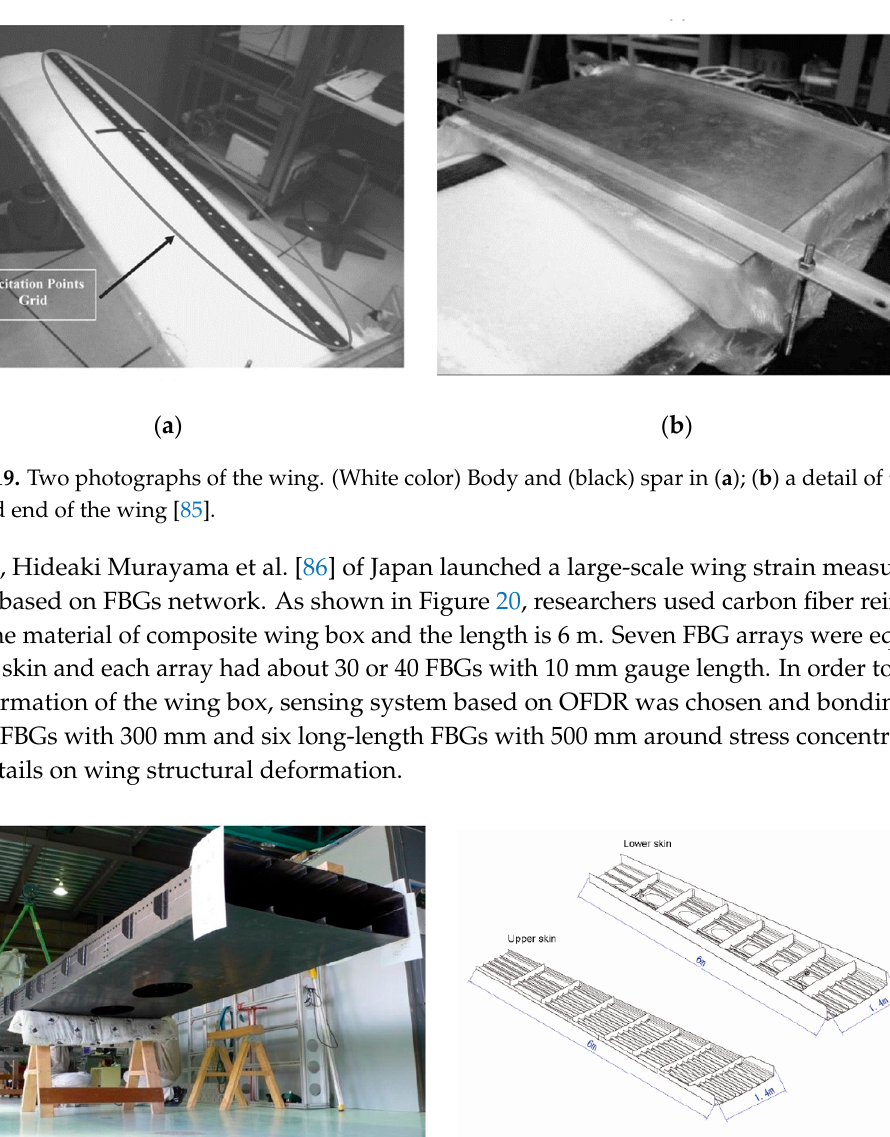
Figure 21. Array layout of FBGs [86].